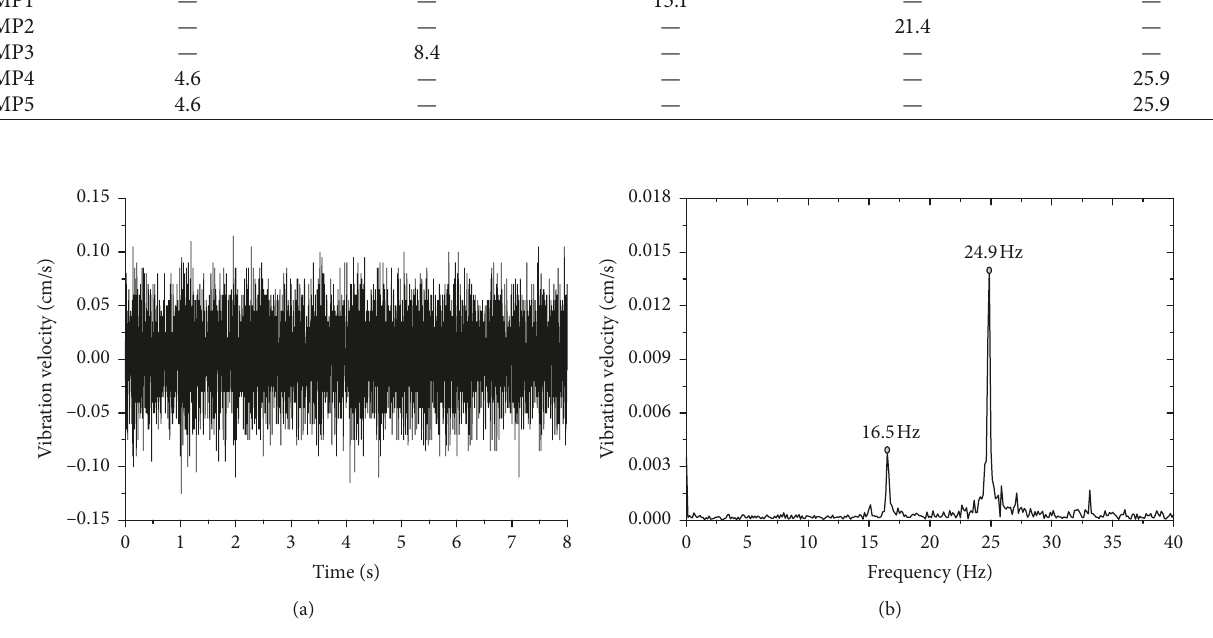
Figure 15: Time-domain waveform and spectrum of MP4, 0.2MPa: (a) time-domain waveform; (b)